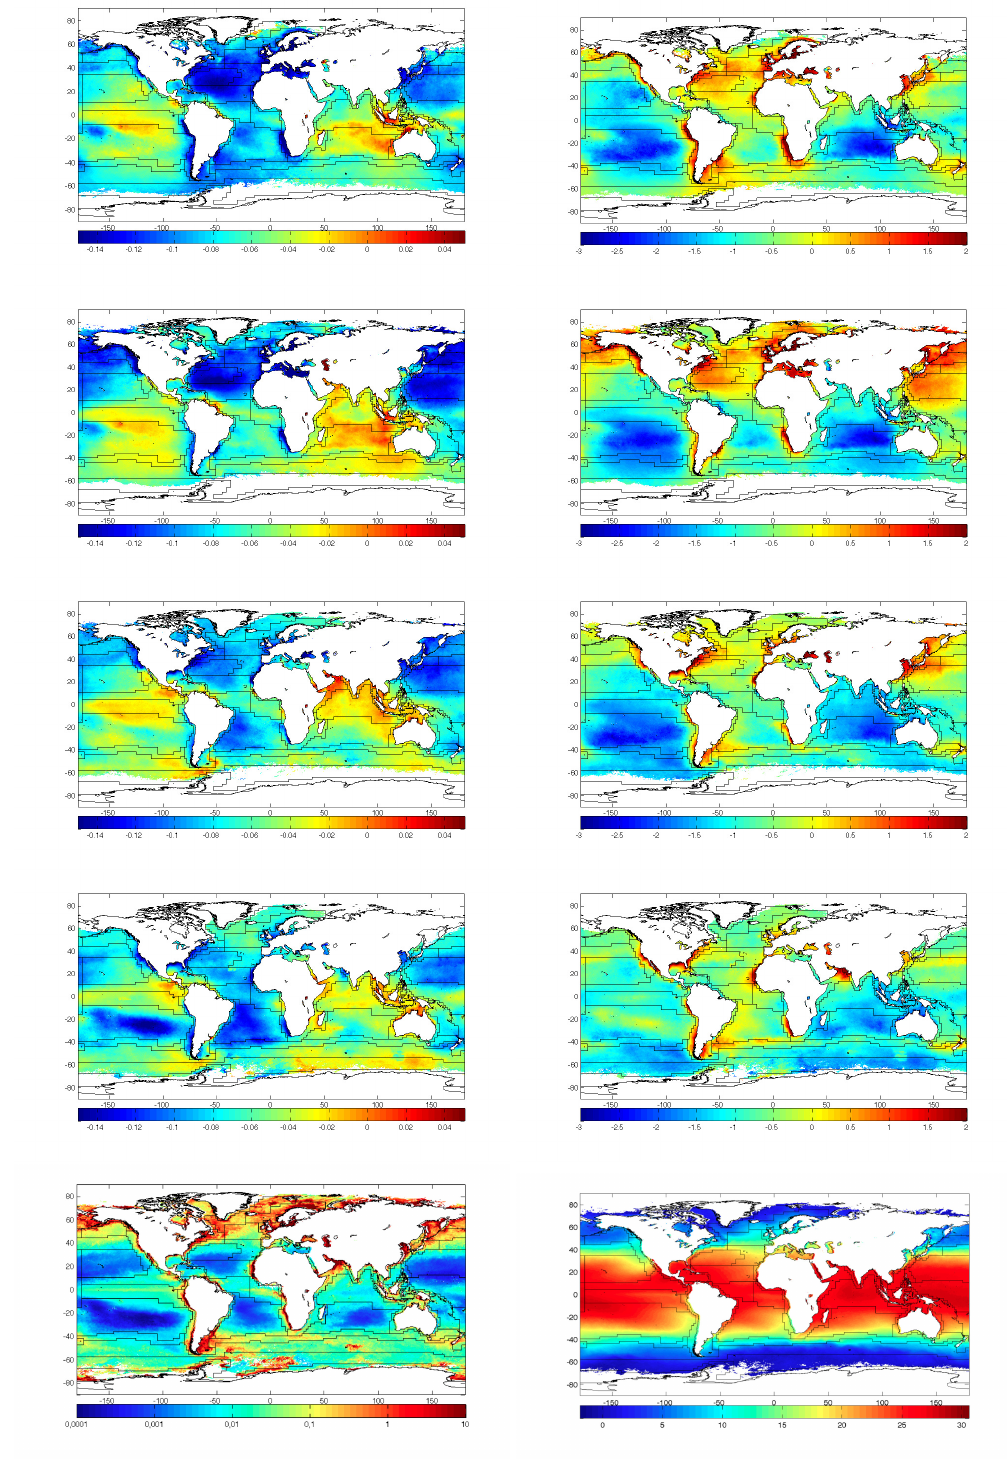
Figure 3. ( left column ) Seasonal mean local slope estimation ˆ a ( x ) for spring, summer, fall and winter. ( right column ) Local intercept estimation ˆ b ( x ) for spring, summer, fall and winter. These are the mean estimations used in the derivation of the fused maps as the one presented in Figure 1. ( bottom row ) Chl- a mean concentration for year 2006 and SST mean for the same